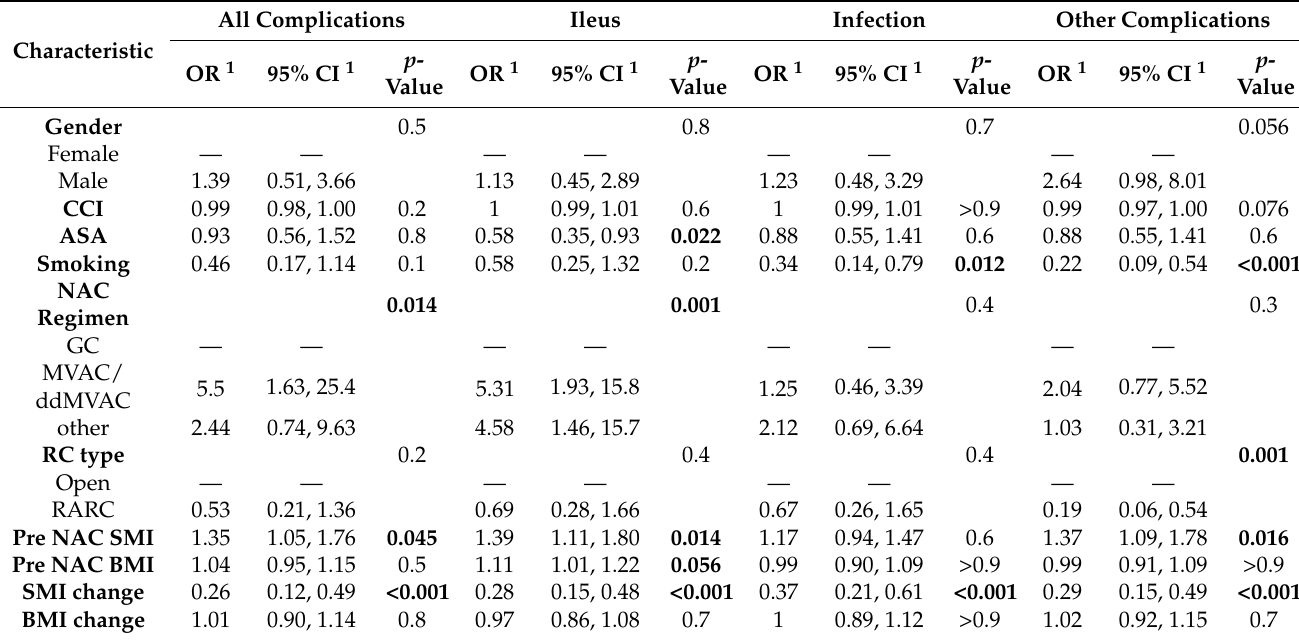
Table 4. Univariable analysis of different complications.